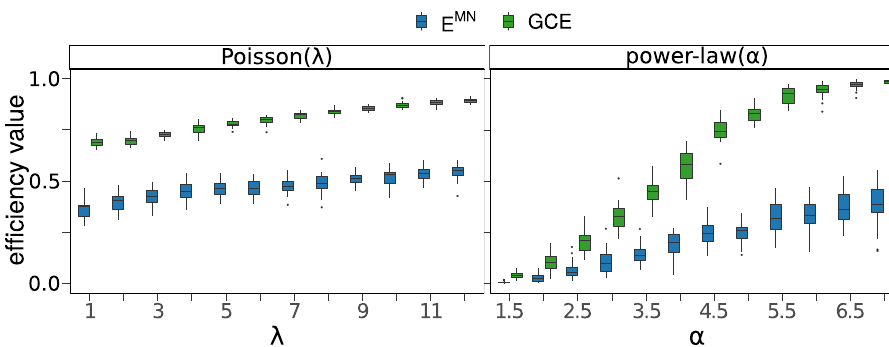
Fig. 3 Comparison of weighted ef fi ciency descriptors for full networks with homogeneous and heterogeneous fl ows. The descriptors are the global communication ef fi ciency GCE and the max-normalized ef fi ciency E MN . For each parameter value the GCE and E MN are evaluated for 30 synthetic networks and their distributions are summarized through boxplots. The fi ve statistics in the boxplots are: the fi rst (Q1) and third (Q3) quartiles, or quantiles of order 25 and 75% (resp. lower and upper box hinges), the median (middle line in the box), the whiskers extend from the smallest to the largest observation in the range [Q1 − 1.5 ⋅ (Q3 − Q1), Q3 + 1.5 ⋅ (Q3 − Q1)]. Observations falling outside this range are outliers, shown as dots. The GCE converges to 1 as the